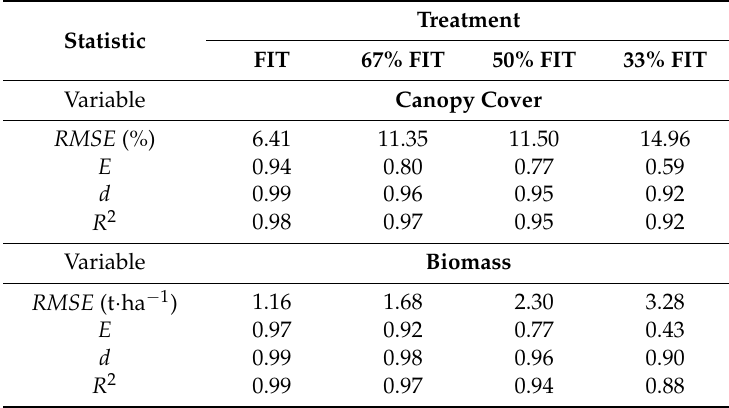
Table 4. Statistical indices of AquaCrop simulated results for the calibration dataset.